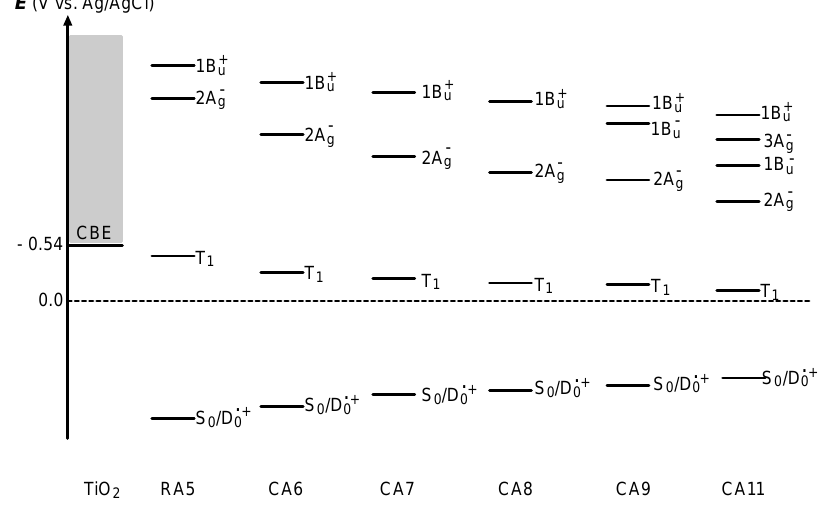
Figure 11. The energies of the singlet, triplet and redox states of RA5 and CA6~CA11 in reference to that of the conduction-bond edge (CBE) of TiO were drawn based on the one-electron oxidation potential listed in Table 2, and the excited state levels were taken from these shown in Scheme 7. Here, the T be the 1/2 of the 2A g– energy [13]. On the other hand, the energy of CBE was calculated by with permission from [11] © 2005, American Chemical